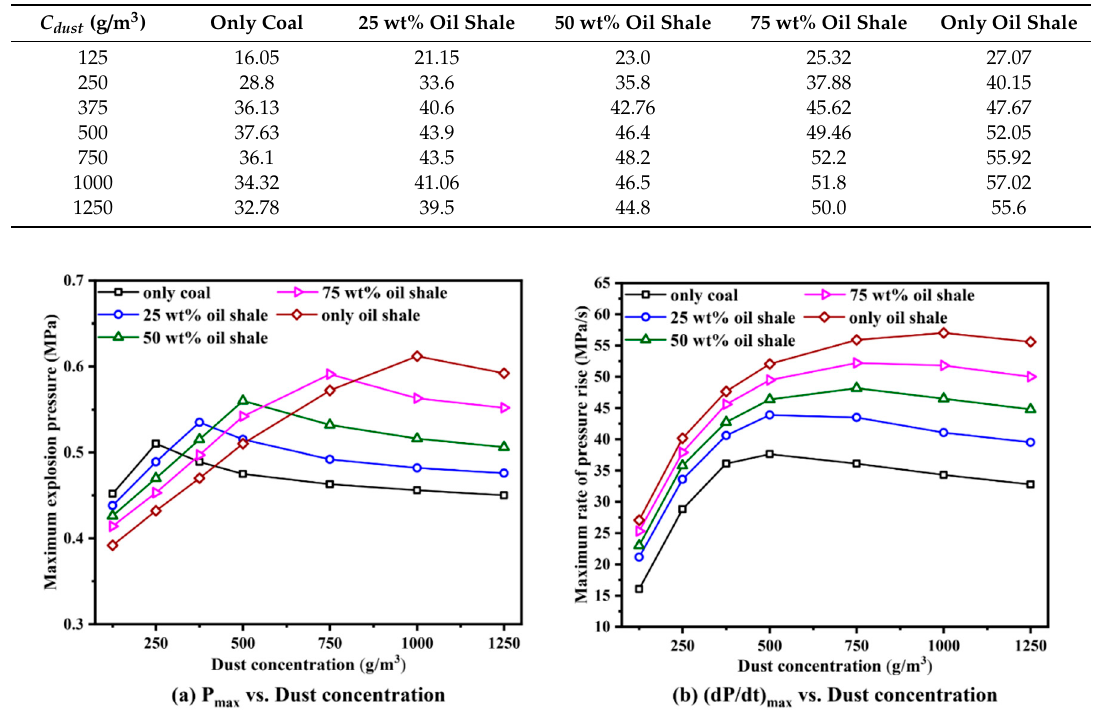
Table 4. The maximum rate of pressure rise (( dP / dt ) max ) (MPa / s) of mixed dust.